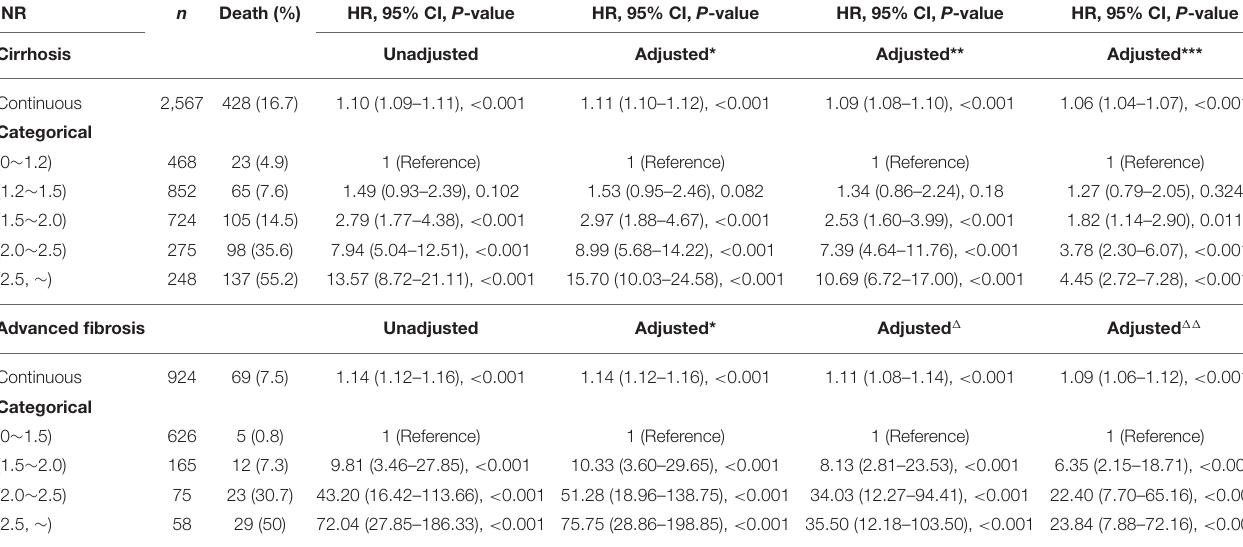
TABLE 3 | The unadjusted and adjusted hazard ratios of INR for 90-day transplantation-free mortality in patients with cirrhosis and advanced fibrosis. INR n Death (%) HR, 95% CI, P -value HR, 95% CI, P -value HR, 95% CI, P -value HR, 95% CI, P -value Cirrhosis Unadjusted Adjusted* Continuous